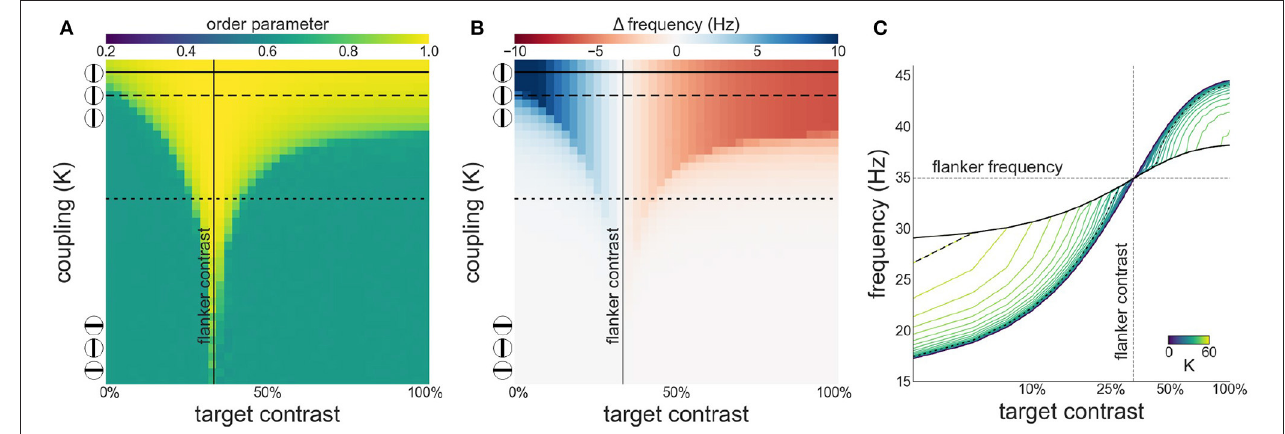
FIGURE 4 | Interactions between target and flanker populations, with flanker contrast fixed at 33% (vertical line). Formatting is identical to Figure 3 : (A) Arnold tongue (B) difference mean effective frequency and intrinsic frequency of target (C) firing frequency of the